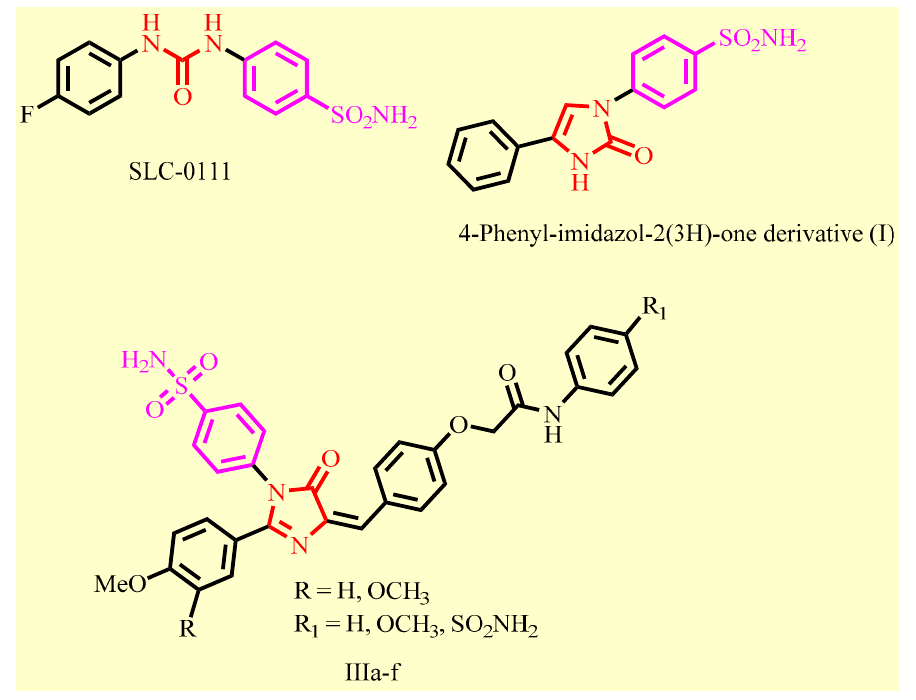
Figure 1. Structure of SLC-0111 , compound I and IIIa–f .